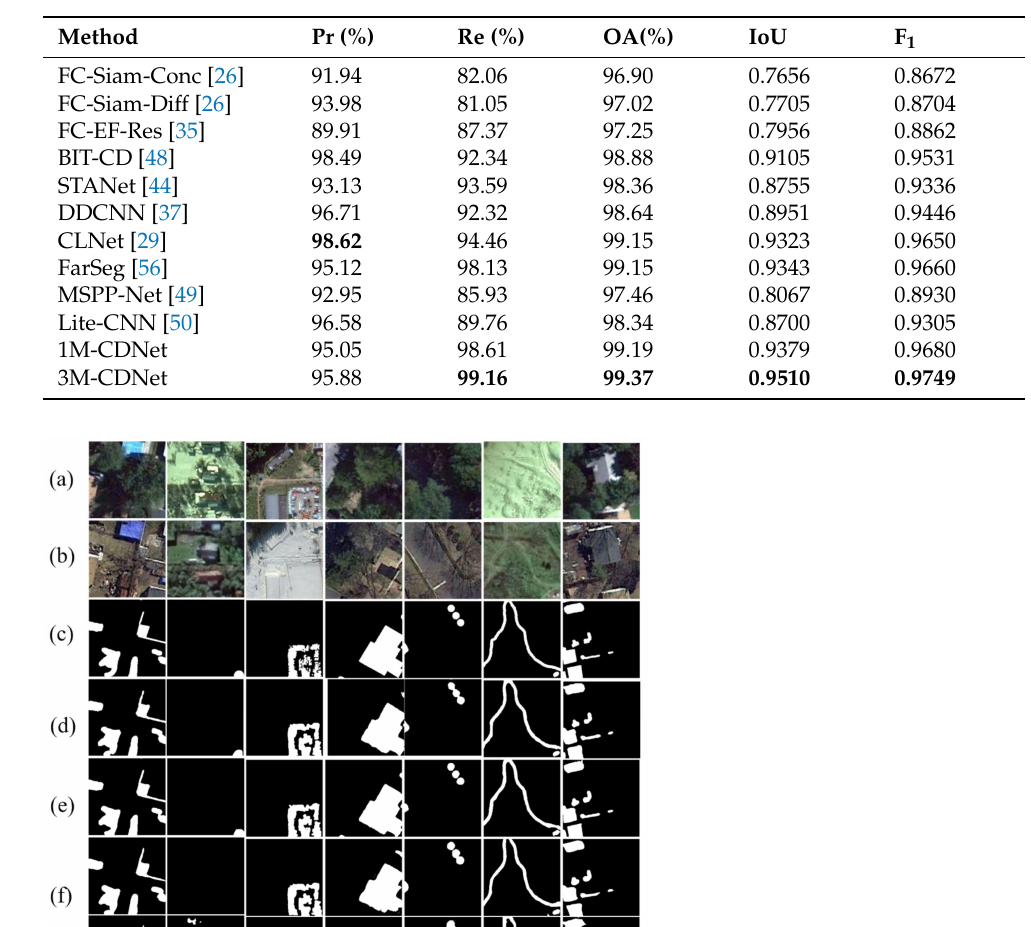
Table 6. Comparison of results on the Season-Varying dataset.